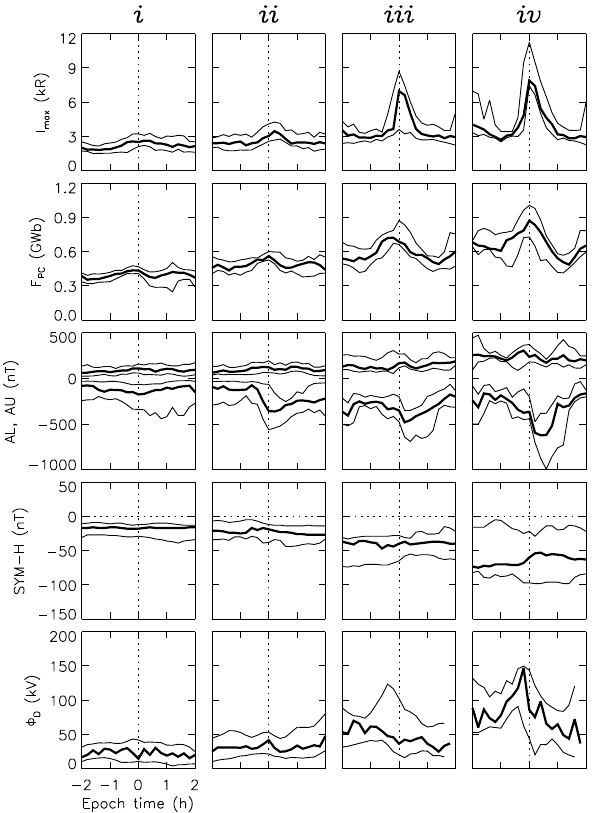
Fig. 1. Superposed epoch analysis of 41 substorms identified by Milan et al. (2008). From top to bottom, the parameters are: the maximum nightside auroral intensity I max as measured by WIC; the open magnetic flux F PC estimated from the size of the polar cap; the AL and AU auroral indices; the SYM-H index; the estimated dayside reconnection rate 8 D . The substorms have been catego- rized by the open flux content of the magnetosphere at substorm onset. Thick and thin lines show the evolution of the median and upper and lower quartile values as a function of epoch time, centred on substorm